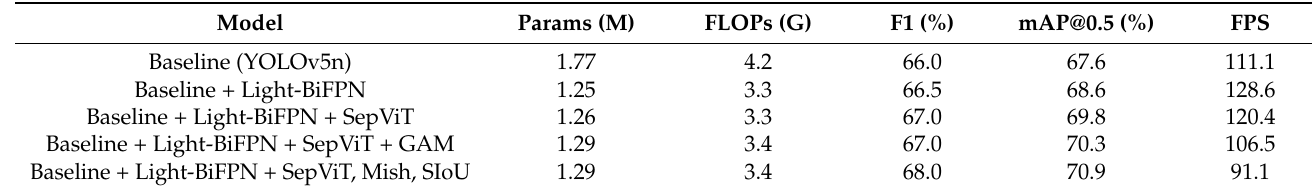
Table 4. Results of ablation experiments with different modified methods.